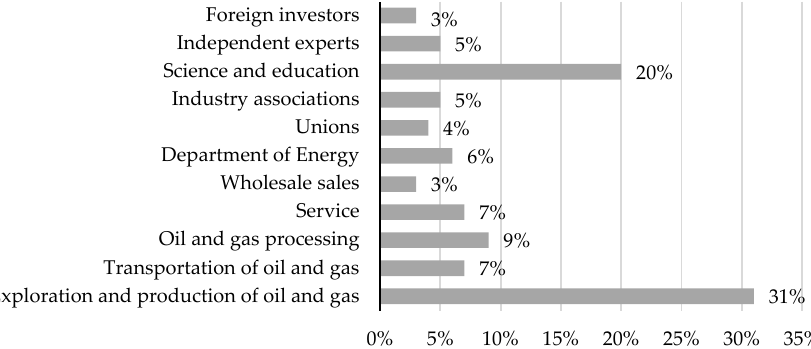
Figure 3. Expert affiliations by sectors of the oil and gas industry.